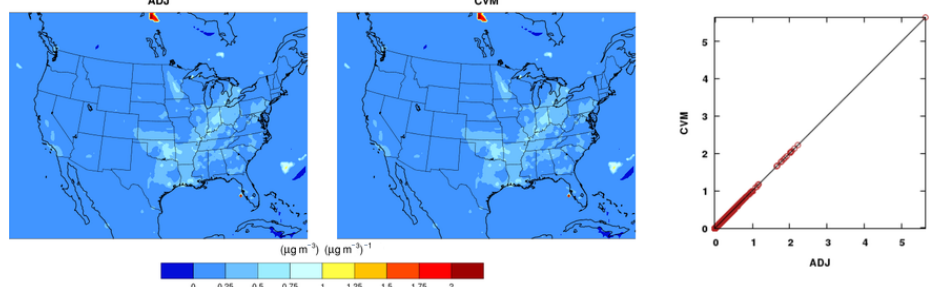
Figure 2. Evaluation of all aerosol subprocesses but thermodynamics with the ADJ (adjoint) against the CVM (complex variable method) sensitivities of the final concentrations of an accumulation-mode aerosol species ASO4J (µgm − 3 ) with respect to the initial concentrations of another Aitken-mode aerosol species ASO4I (µgm − 3 ) from a 1d test run. The perturbation size for the CVM is